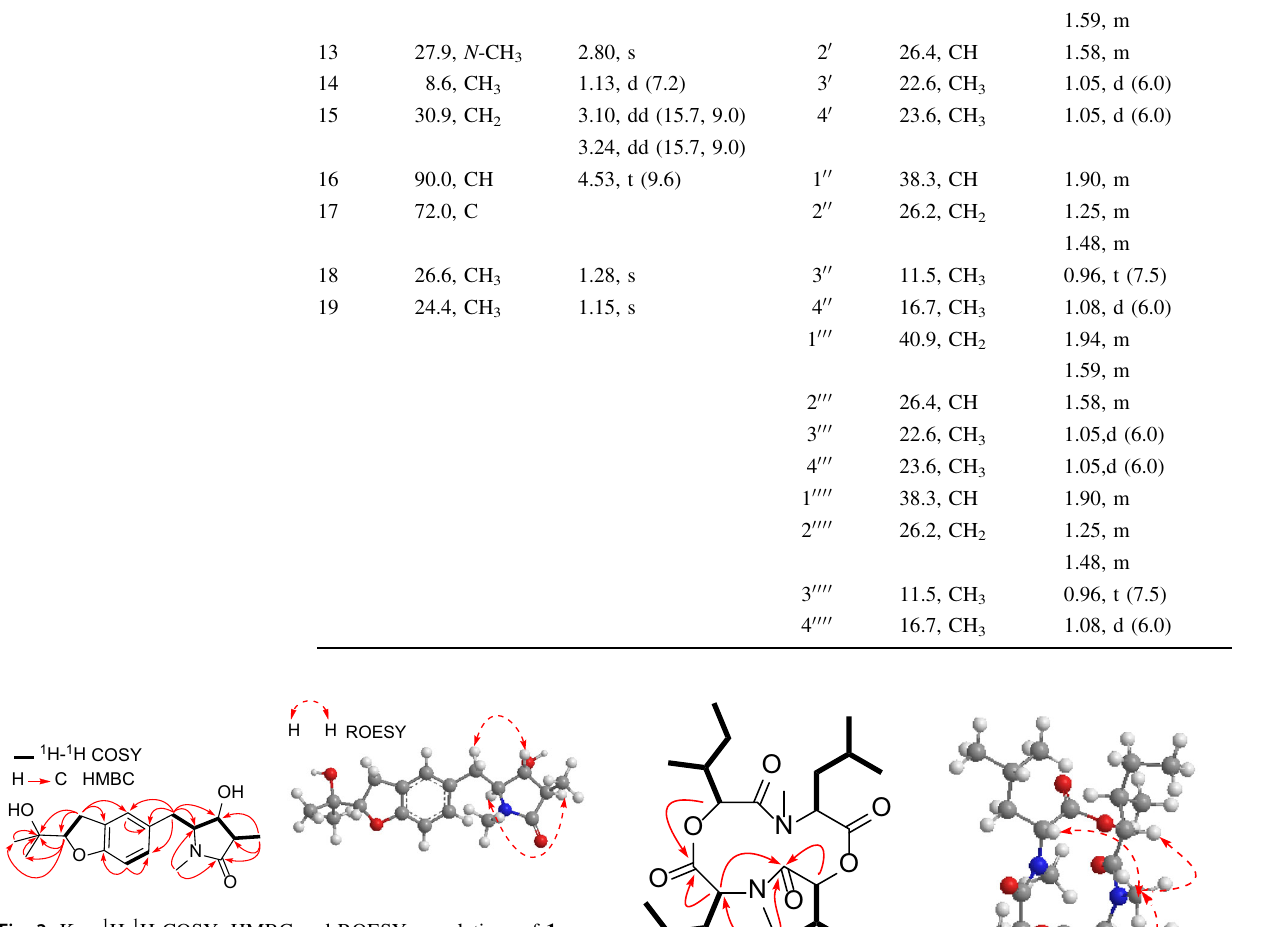
Fig. 2 Key 1 H- 1 H COSY, HMBC and ROESY correlations of 1